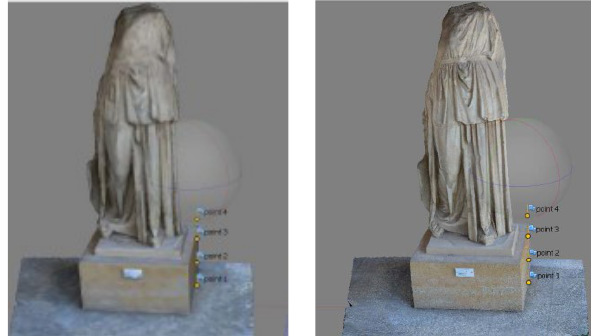
Figure 5: The 3D polygonal mesh on the left and the textured 3D mesh on the